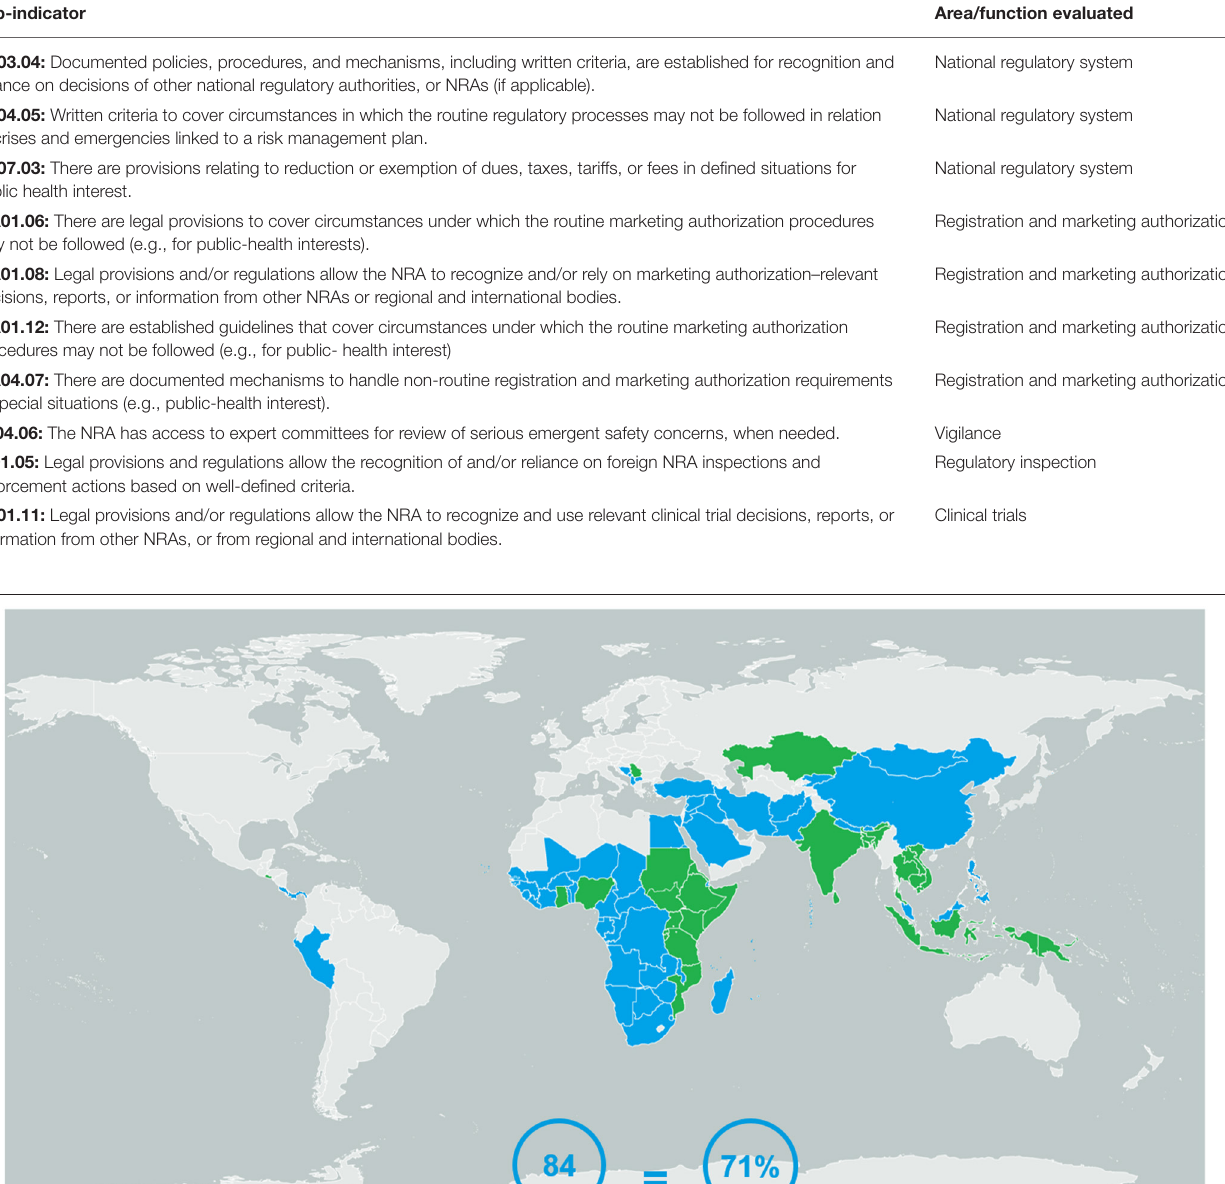
TABLE 1 | Global benchmarking tool sub-indicators relevant to emergency preparedness. Sub-indicator